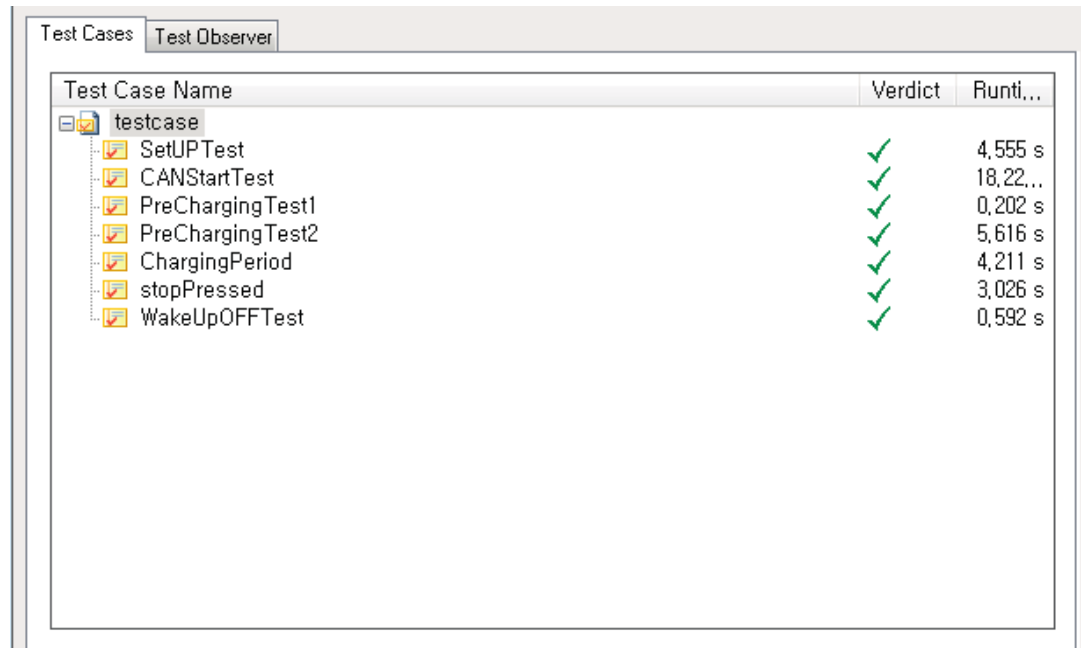
Figure 10. Test runner in CANoe after successfully testing the press stop button